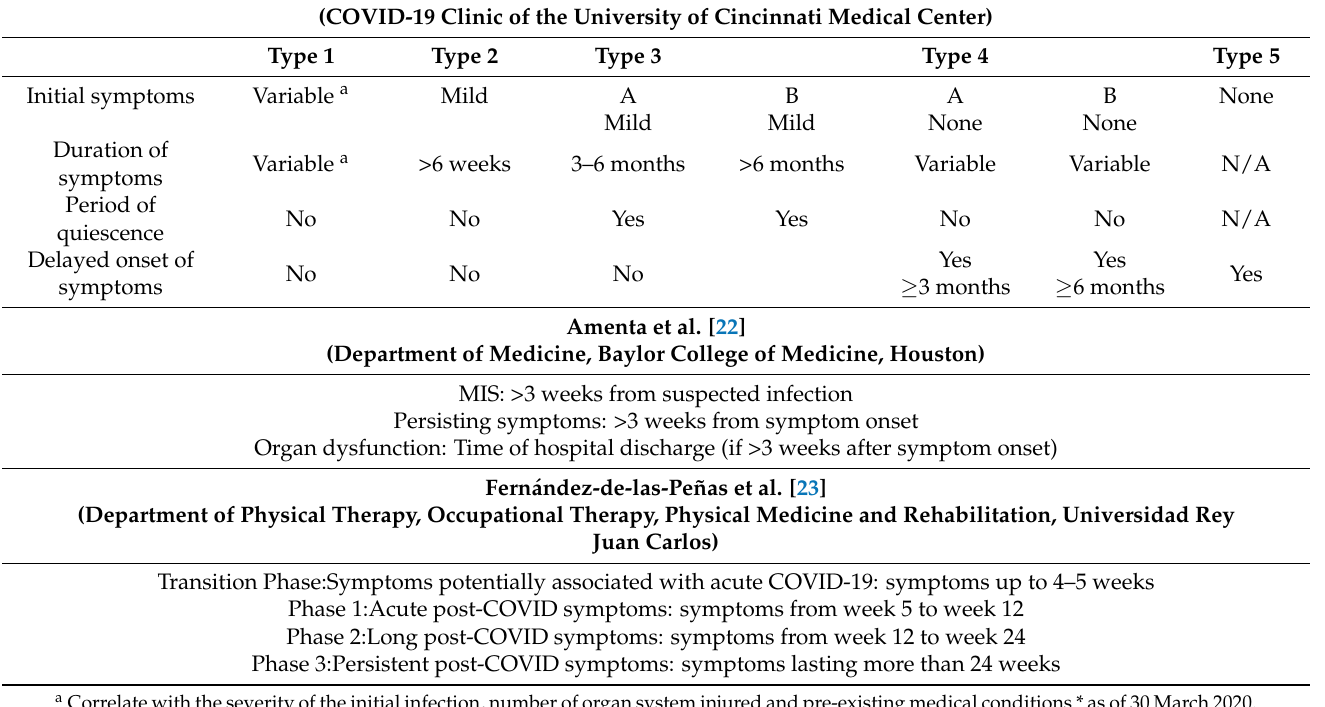
Table 1. Classifications of post-COVID syndrome